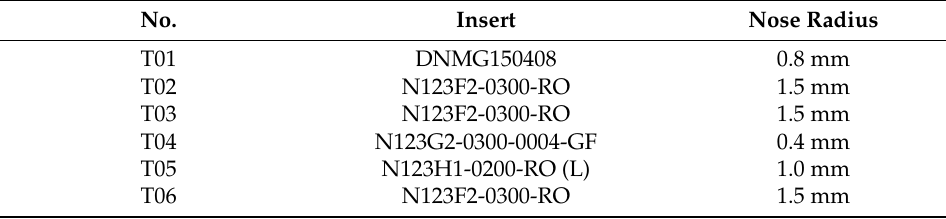
Table 2. Cutting tool inserts and their